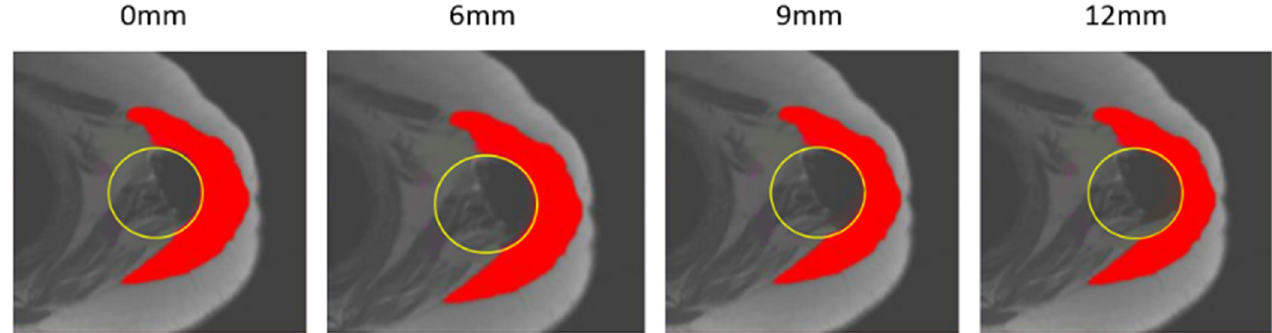
Fig 6. Simulation of lateralizations on SliceOmatic ™ in axial view. 2D representation on an MRI image of the displacement of a 2D slice of ILSS (stamped in the MRI image) along the X axis at 0, 6, 9 and 12mm ( from left to right ). Yellow circle = slice of ILSS in 2D; In red = deltoid muscle.